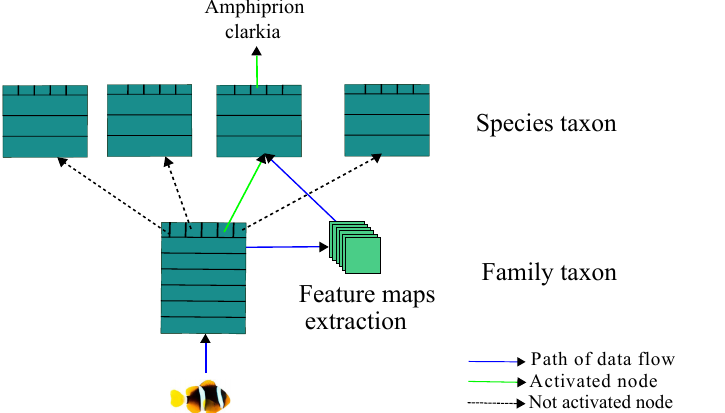
Figure 5. The proposed approach of Tree-CNN hierarchical classification for fish species recognition. The output of the root node is used to select the leaf node (family taxon) at the second level. Then, the leaf node classifies the fish in the species